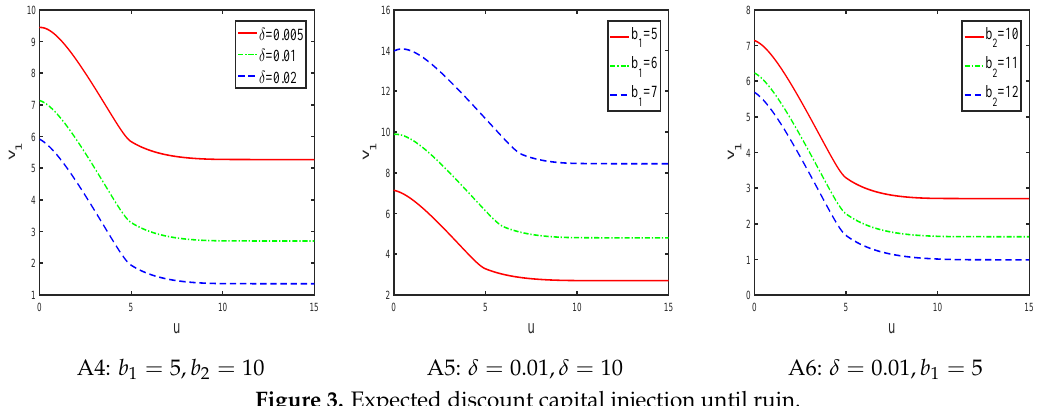
Figure 3. Expected discount capital injection until ruin.